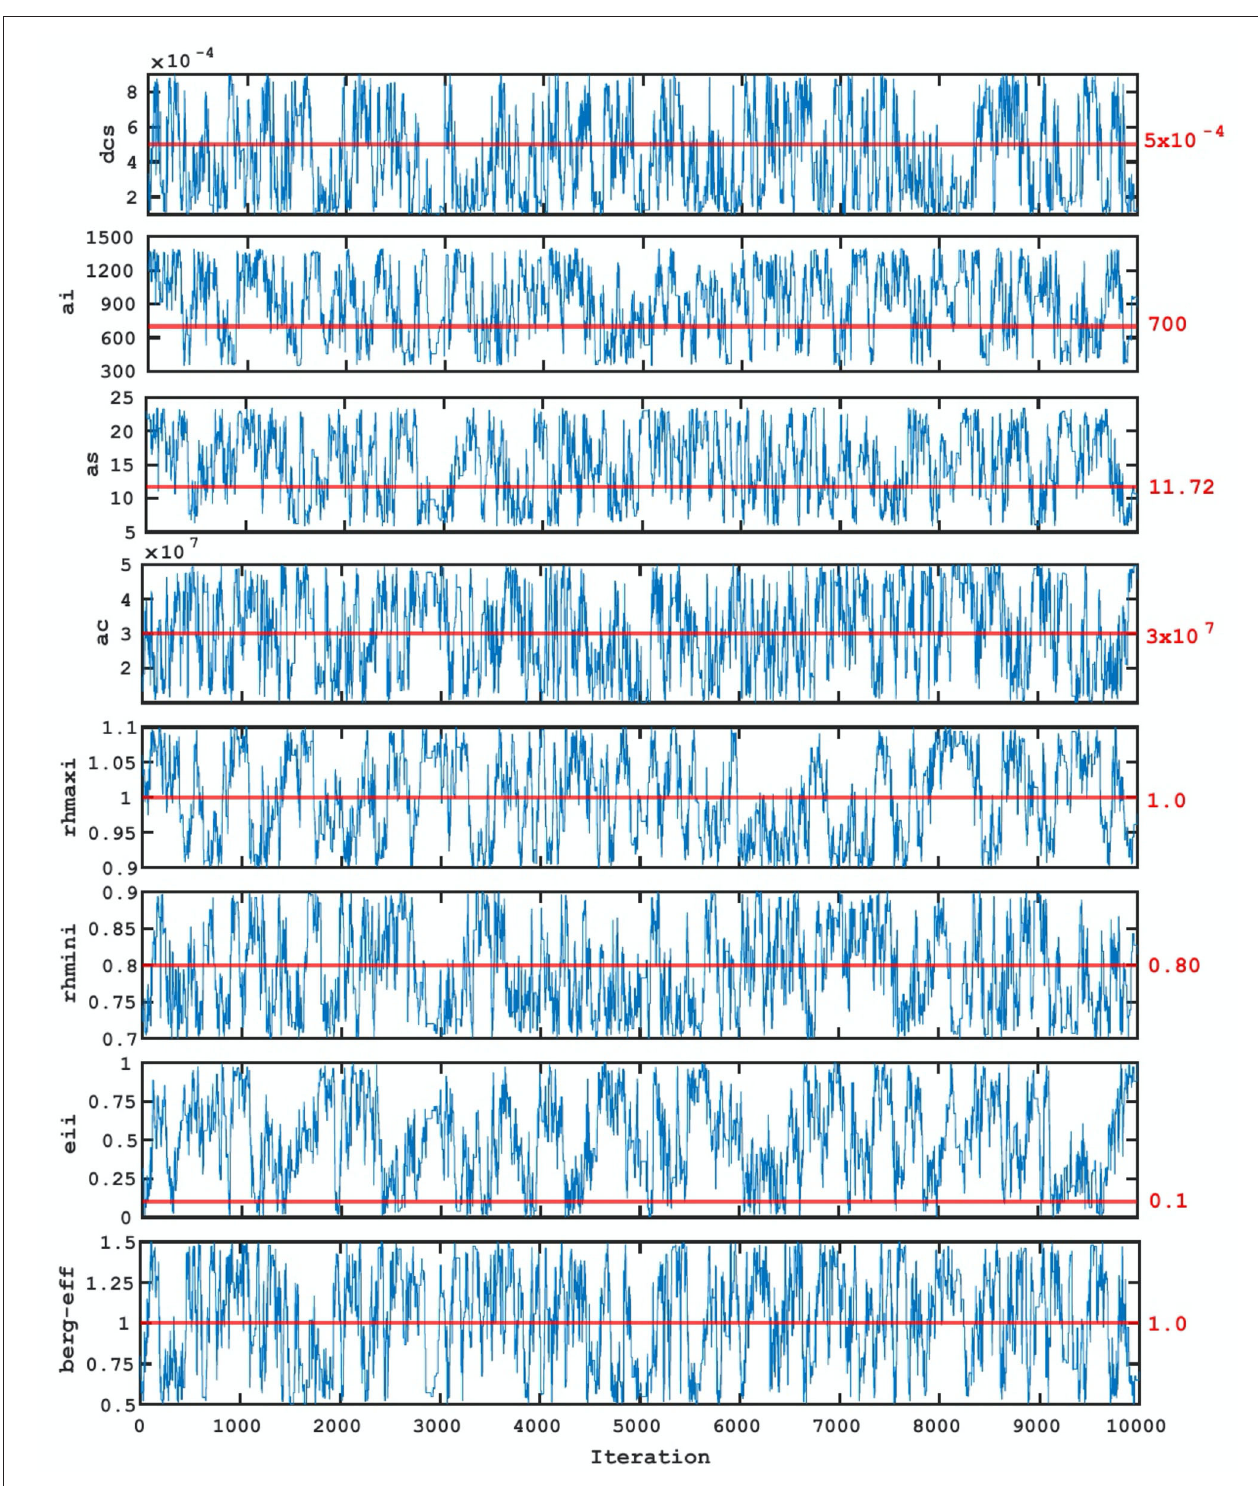
FIGURE 12 | Chains of parameters from MCMC samples. The horizontal red line (and the value shown in red) indicate the default parameter value used in NCAR SCAM6.